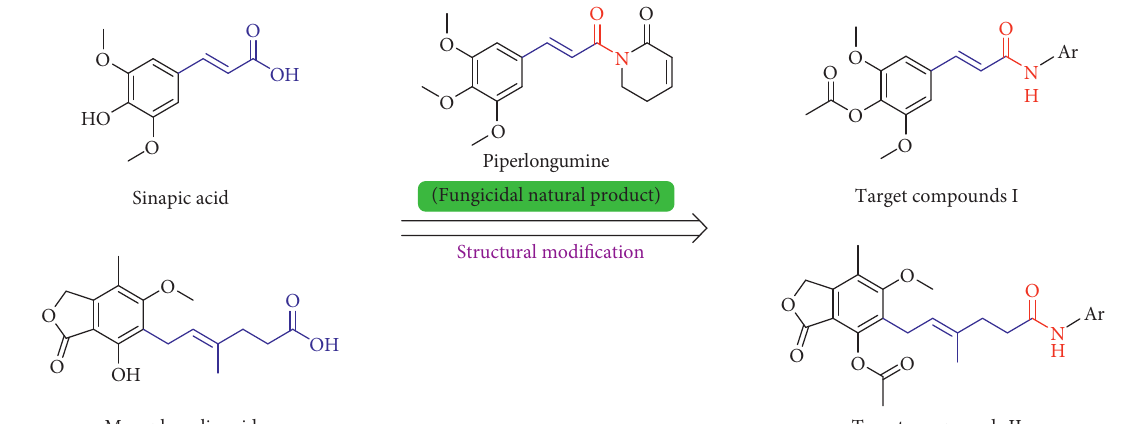
Figure 3: Molecular design strategy in this